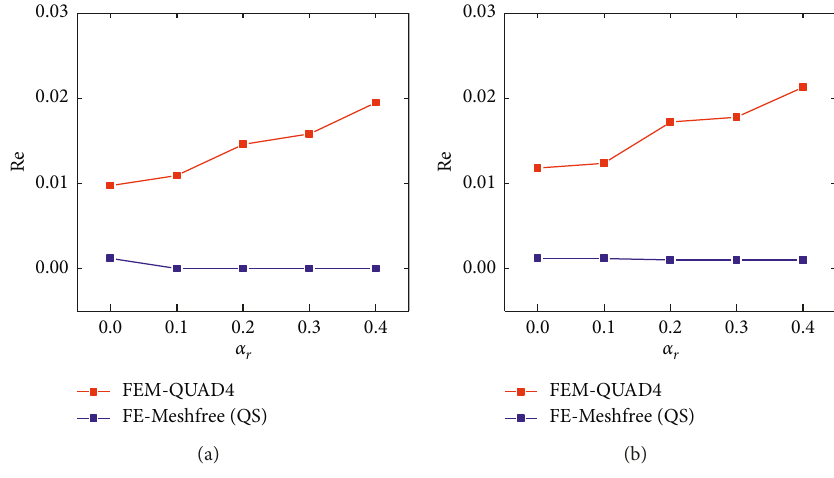
Figure 18: Error in the computed first two frequencies for distortion sensitivity test.